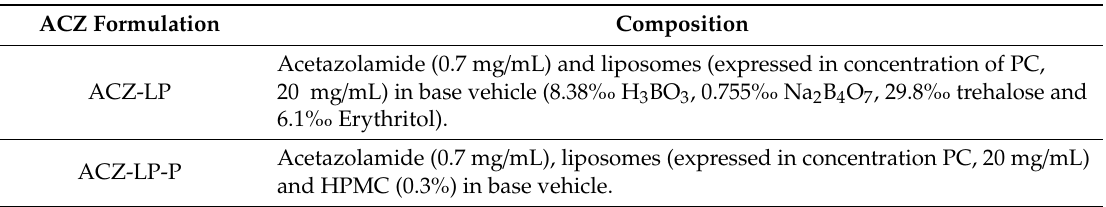
Table 1. Composition of liposomal